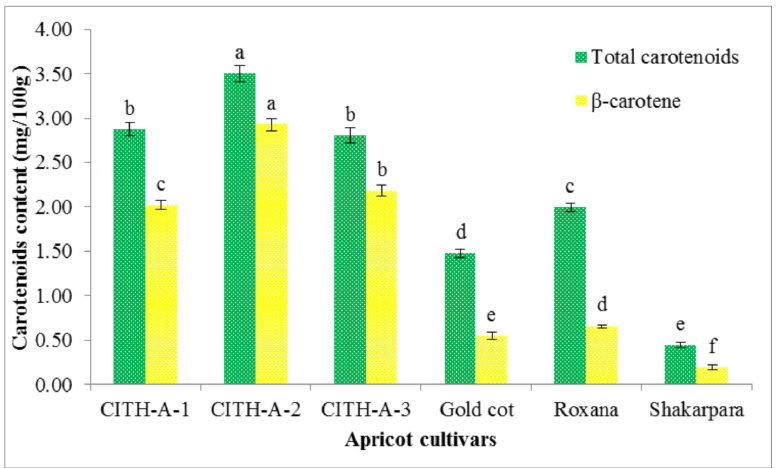
Figure 4. Total carotenoids and β -carotene content of apricot genotypes from India. The same letter (a, b, c, d, e or f) above a similarly coloured column indicates no significant differences in values ( p < 0.05). The β -carotene content of apricot genotypes varied significantly, ranging from 0.19 to 2.93 mg/100 g (Figure 4). Among the genotypes, ‘CITH-A-2’ had the most β -carotene (2.93 mg/100 g) and ‘Shakarpara’ had the least (0.19 mg/100 g). As a result, β -carotene